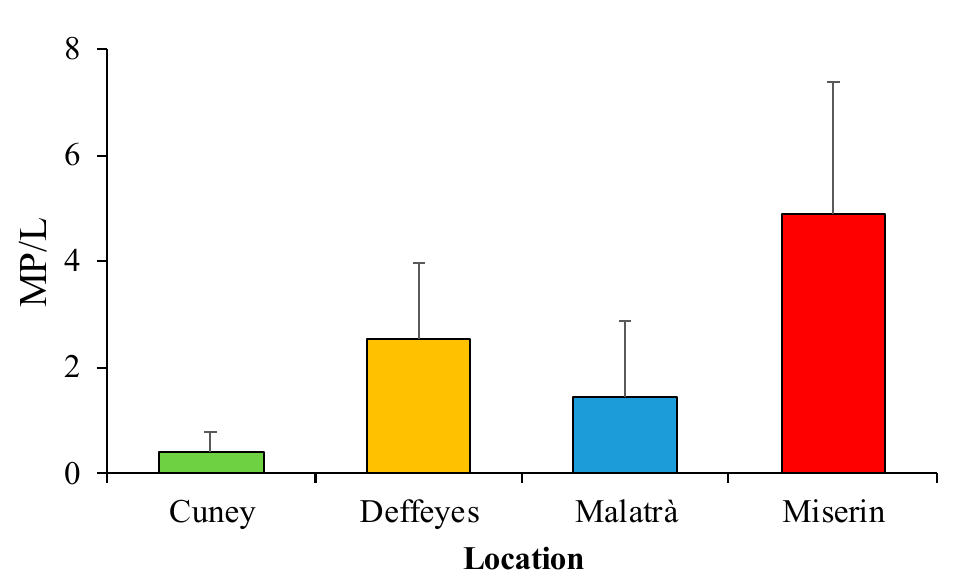
Figure 3. Concentration (mean ± SE) of MPs (expressed in MPs/L of melted snow; mean ± SE) in snow samples from the four locations in the Aosta Valley (Western Italian Alps).